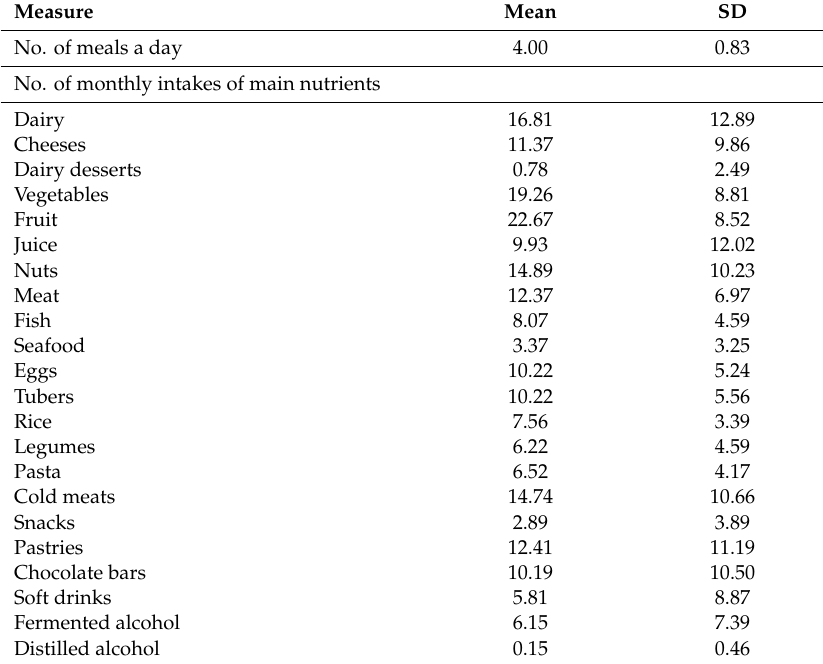
Table 2. Dietary habits of the study population prior to the intervention.